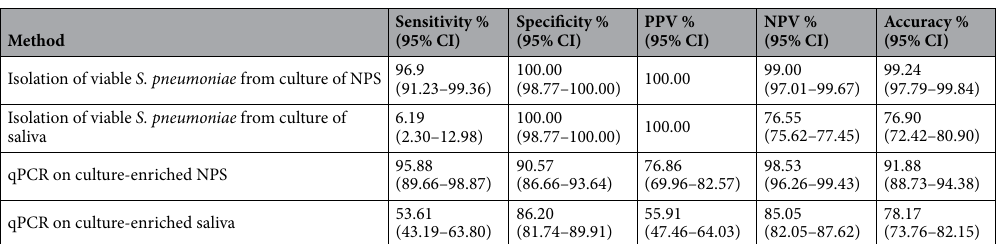
Table 2. The accuracy of Streptococcus pneumoniae detection in paired saliva samples and nasopharyngeal swabs from n = 394 children. Samples were tested using culture method and molecular methods applied to DNA extracted from culture-enriched (CE) samples and applying thresholds of < 40 C T in piaB - and lytA - specific qPCRs for a sample positivity. Measures of diagnostic accuracy were calculated by comparing the number of samples positive by a method with the overall number of n = 97 children identified as carriers of S. pneumoniae based on isolation of viable pneumococcus either from saliva or nasopharyngeal sample. NPS nasopharyngeal swab, PPV positive predictive value, NPV negative predictive value, 95% CI 95% confidence